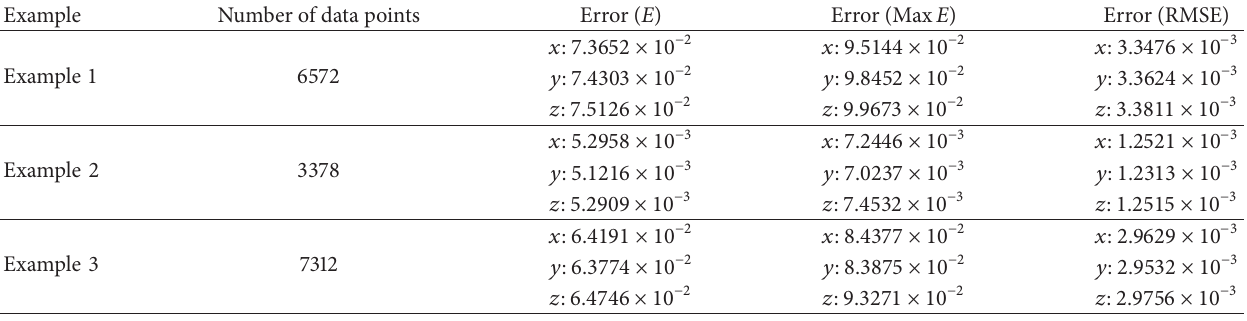
Table 1: Number of data points and error values (for each coordinate) of the three examples discussed in this paper.